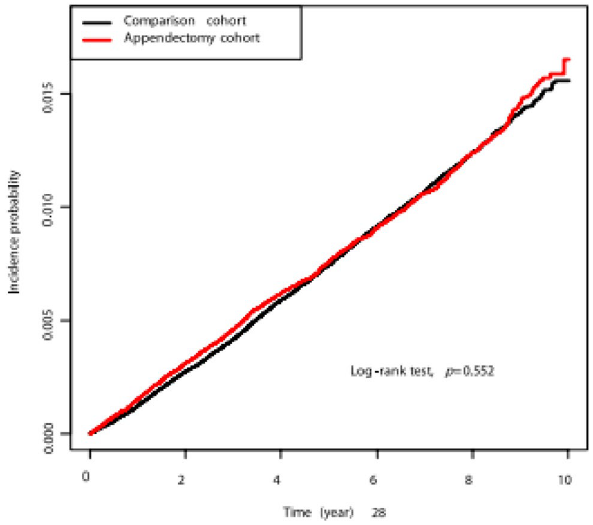
Figure 1. Kaplan–Meier curves of incidence probability for gastrointestinal cancers according to appendectomy in the overall